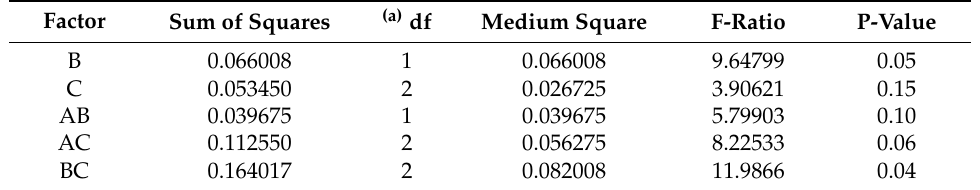
Table 3. Variance analysis summary for the PLA samples with Sg45_w as the optimization response and the factors printing speed (A), layer height (B) and sample thickness